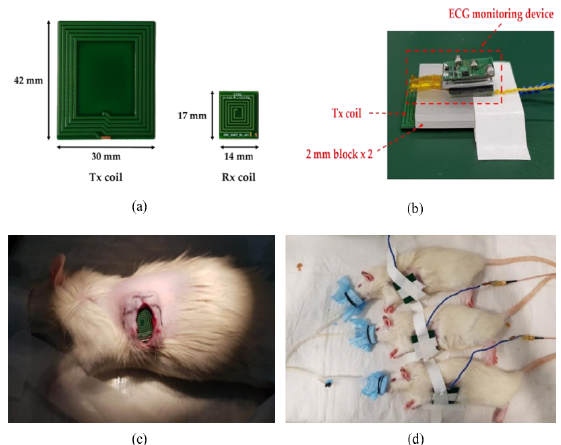
Figure 8. WPT system for implantable ECG monitoring device: ( a ) fabricated Tx and Rx coils; ( b ) mainboard, battery, and Rx coil positioned similar to the ECG device; ( c ) implantation of the ECG device in the rat; ( d ) WPT process in anesthetized rats